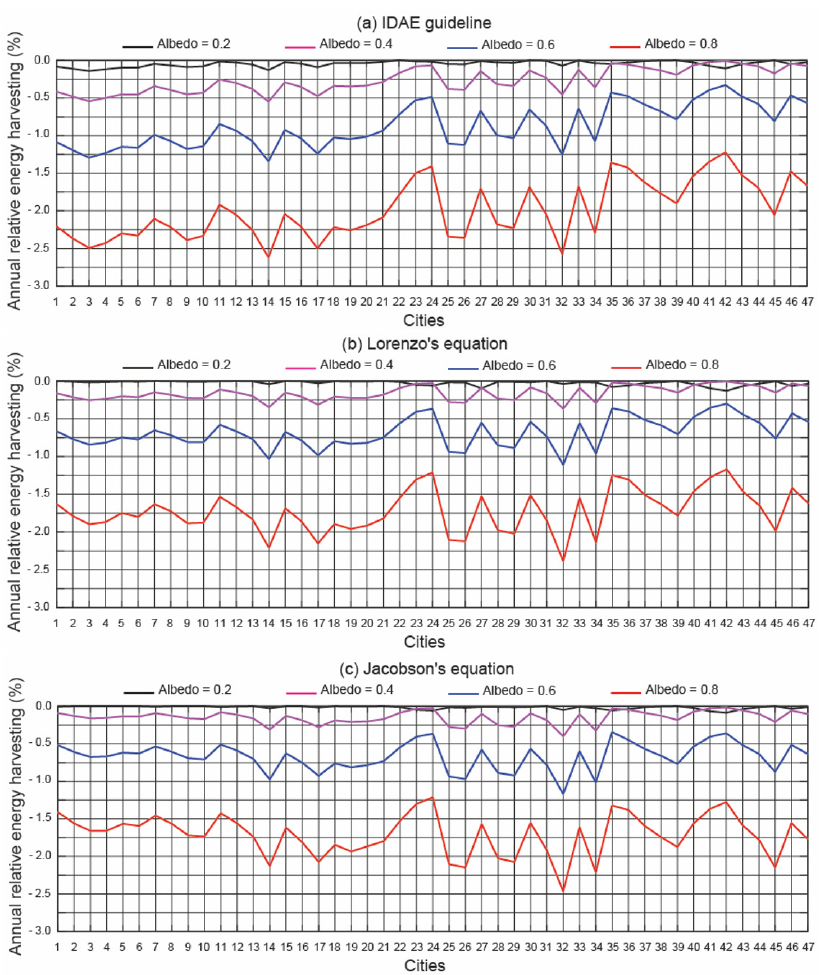
Figure 9. Yearly REH between the equations as function of latitude and the method based on maximizing the total irradiation incident on a tilted